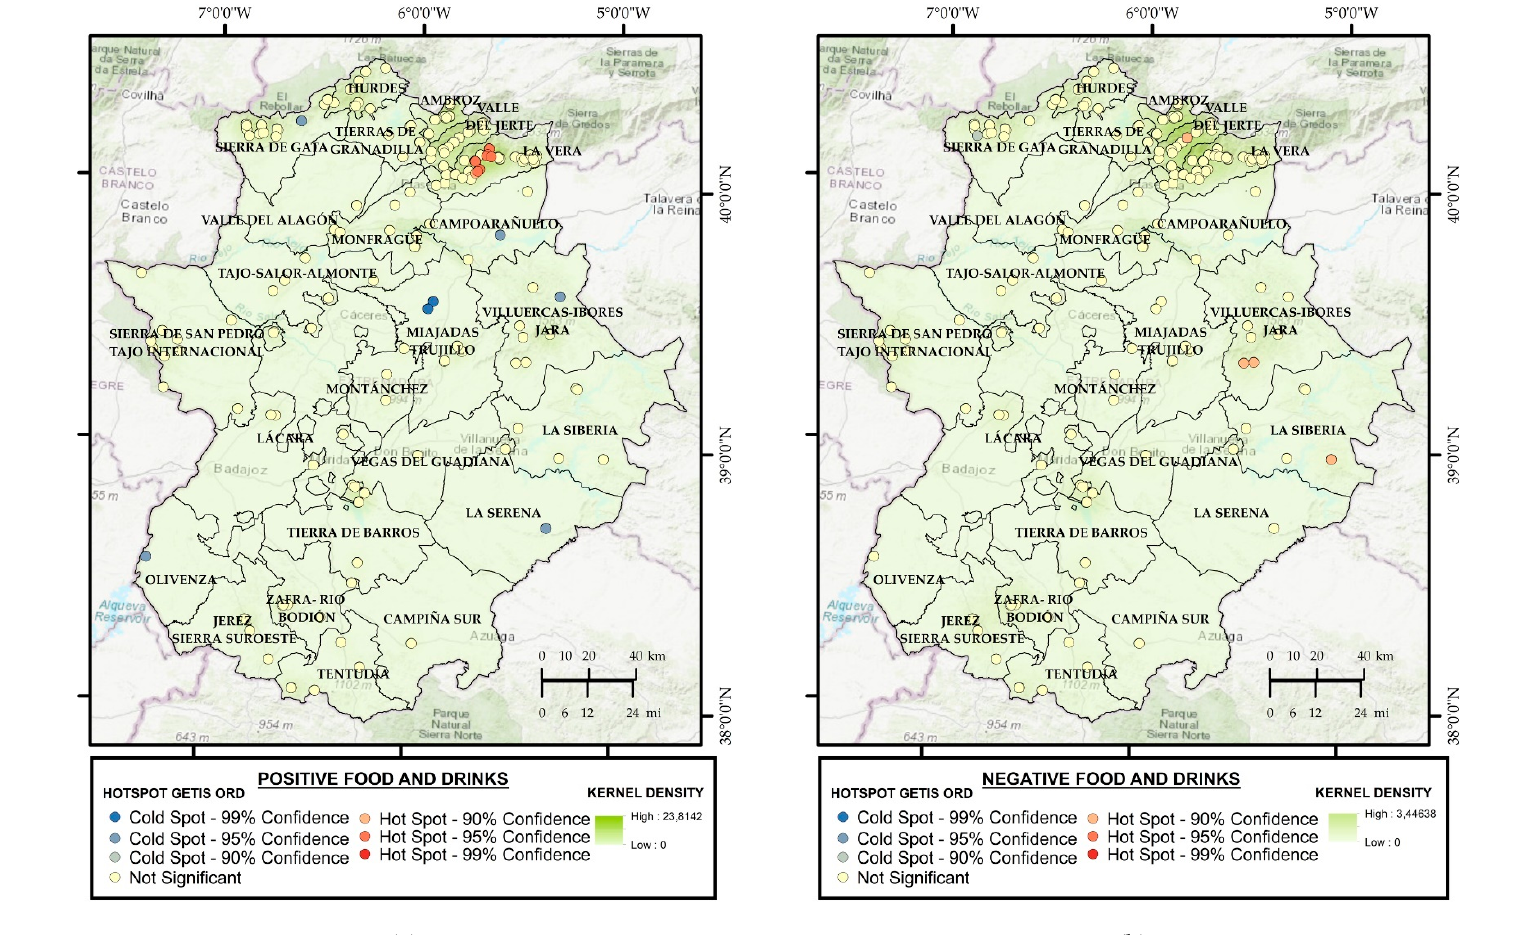
Figure 4. Gi* Getis Ord Food and Drinks Positive ( a ) and Negative ( b ) mentions. The opinions on value for money amount to 1477, of which 73.6% are positive and 26.4% negative. In general terms, it can be observed that this aspect has a worse reputation among tourists. The analysis of spatial patterns (Table 5) shows the distribution of the values of this parameter over the region of Extremadura. It reflects that the positive mentions follow a random distribution pattern while negative mentions are grouped together. Table 5. G Getis Ord test on Value for Money. Type of